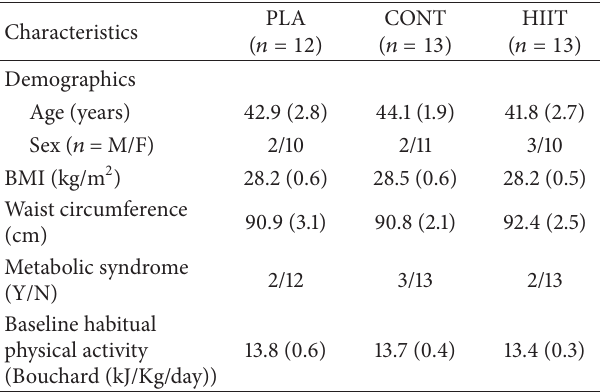
Table 2: Baseline participant